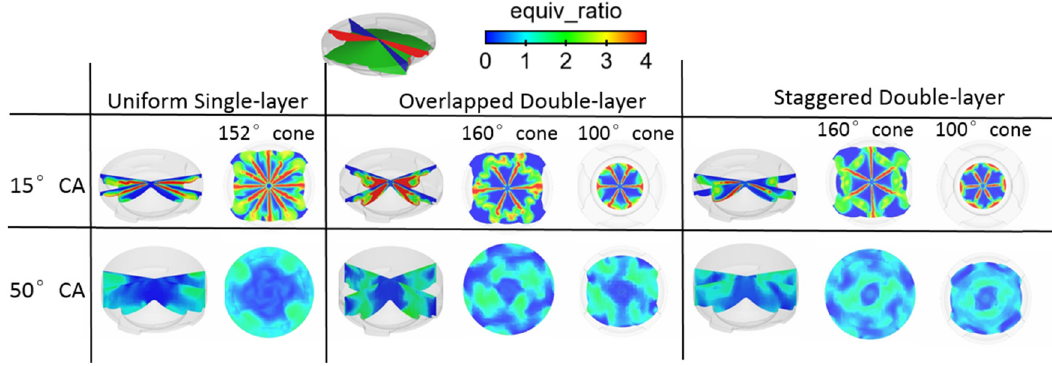
Figure 21: The equivalence ratio contours for di ff erent arrangements of nozzle holes.